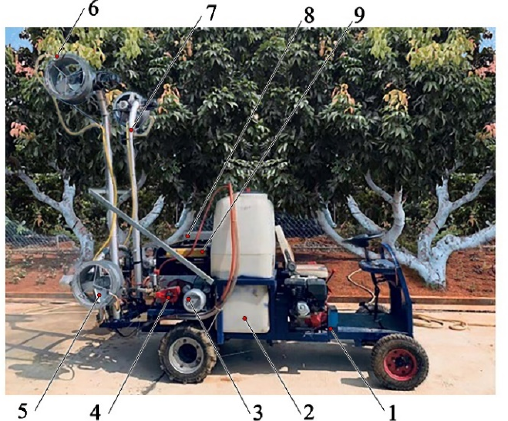
Figure 3. Display of the self ‐ created axial ‐ flow air ‐ assisted sprayer: ( 1 ) vehicle platform; ( 2 ) pesticide box; ( 3 ) electric motor; ( 4 ) liquid pump; ( 5 ) axial ‐ flow fan; ( 6 ) ring ‐ like nozzle group; ( 7 ) adjustable profile strut; ( 8 ) control cabinet; ( 9 ) gasoline generator.